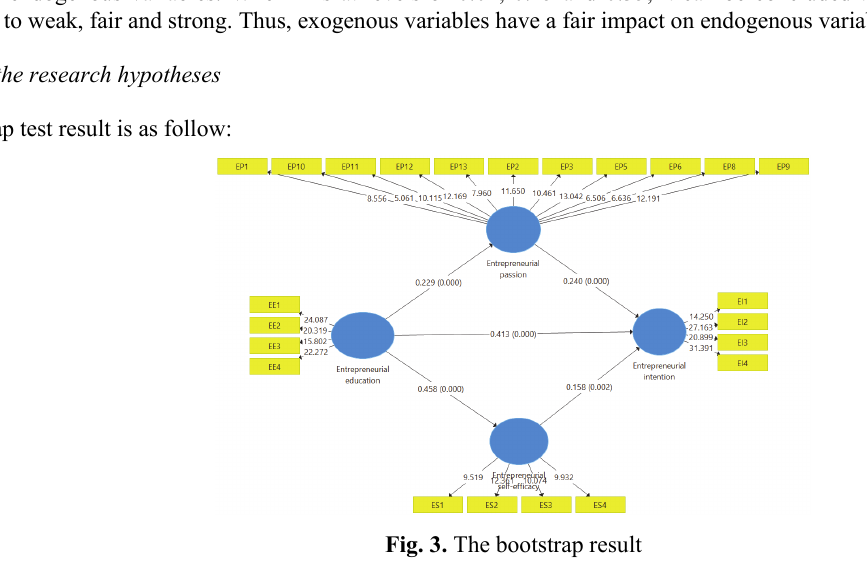
Path Coefficients (Mean, STDEV, T-Values, P-Values)